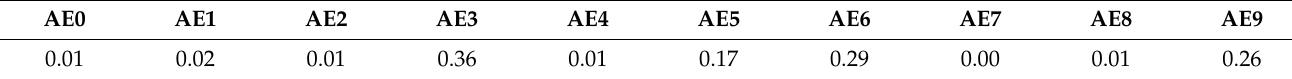
Table 5. AE values for all 10 IP’s.